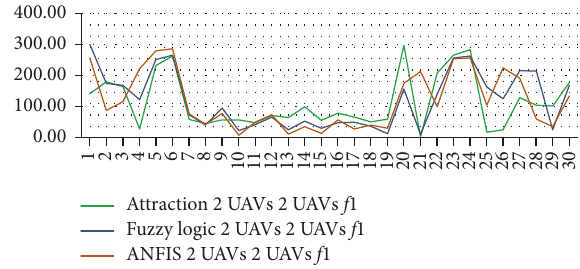
Figure 23: La Palma results comparison for 3 UAVs in distributed formation.